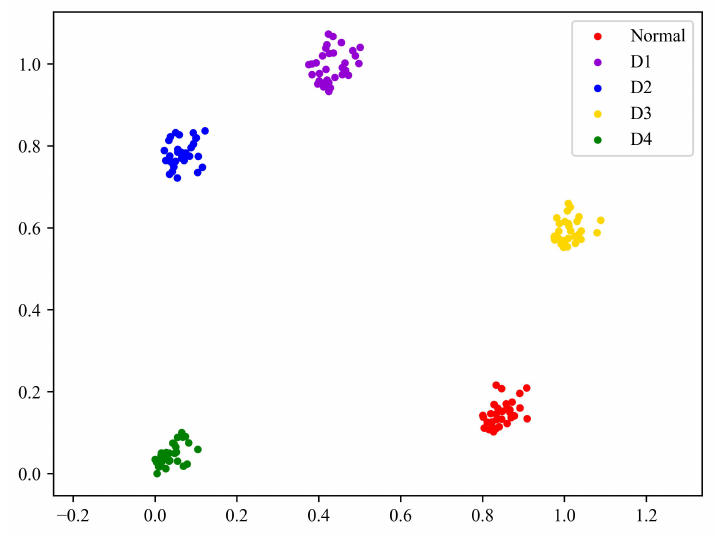
Figure 12. Visualization of model